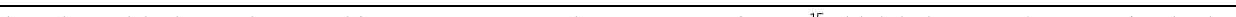
Fig. 5 The Rap1b binding to talin is crucial for integrin activation. a The HSQC spectra of 50 μ M 15 N-labeled talin-F0_DM (K15A, R35A) in the absence (black) and presence of 125 μ M GMP-PNP loaded Rap1b (red). b Integrin activation assay in CHO A5 cells, which stably express integrin α IIb β 3 . Double mutations (K15A, R35A) in talin-H substantially decreases integrin activation. The data are shown as means ± S.E.M. from four independent experiments. * p < 0.05. c Static adhesion of talin 1/2dko fi broblasts, expressing either ypet alone, ypet-tagged talin WT, or ypet-tagged talin DM (K15A, R35A). Number of adherent cells was quanti fi ed by measuring absorbance of crystal violet staining. Values measured for talin WT-transduced cells were set to one in each of six independent experiments. Values are given as mean ± S.E.M. * p < 0.05 and ** p < 0.01. d Spreading of talin 1/2dko fi broblasts expressing ypet (green), ypet-tagged talin WT (red), or ypet-tagged talin DM (blue) on a fi bronectin-coated surface, measured 5, 15, 30 min, 1, 2 and 4 h after plating. N = 5. e Confocal images of ypet-tagged talin WT or ypet-tagged talin DM cells on FN-coated round micropatterns stained for paxillin (red) and F-actin (blue). Ypet signal is shown in green. Scale bar 10 μ m. Focal adhesion area per cell area ( f ), focal adhesion number per cell ( g ), and focal adhesion size ( h ) of ypet- tagged talin WT and ypet-tagged talin DM cells on FN-coated micropatterns. i Ypet fl uorescence intensity within paxillin-positive focal adhesion area in relation to the cellular ypet fl uorescence. N = 5; 10 – 15 talin WT and talin DM-expressing cells in each measurement were analyzed. All values are given as mean ± S.E.M. * p < 0.05 and ** p <